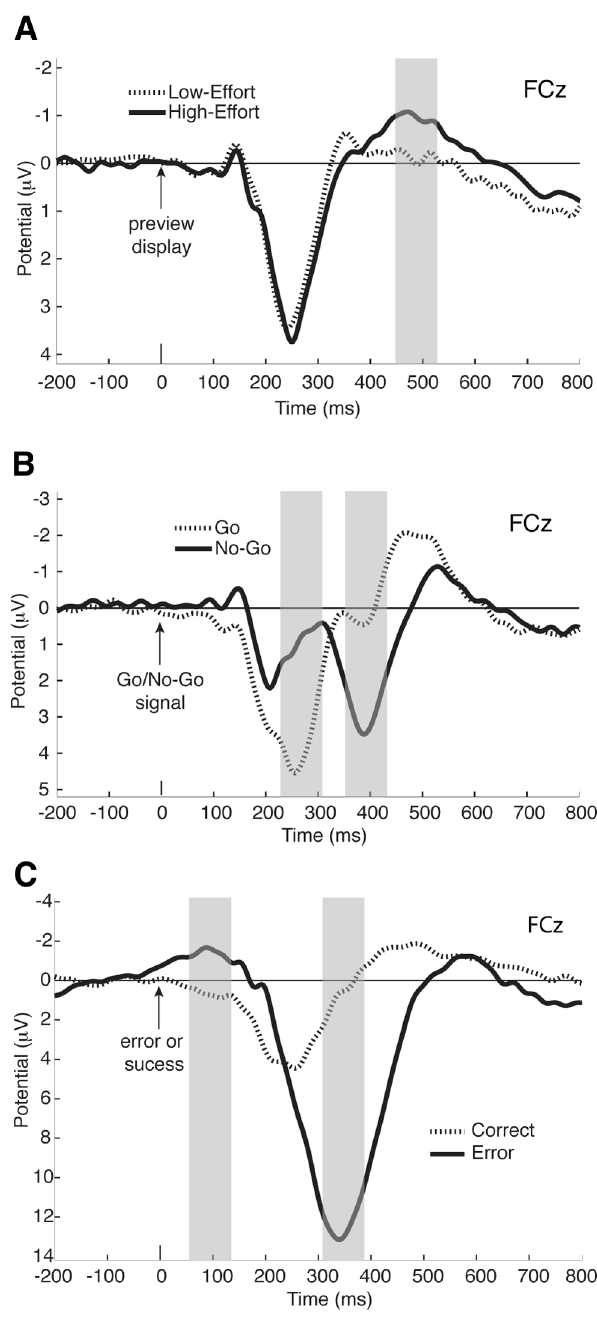
Figure 3. Grand-average ERP waveforms recorded at fronto- central electrode FCz. Negative voltages are plotted upward by convention. Shaded regions represent the time windows used for statistical analyses ( A ) ERPs elicited by the Low-Effort and High-Effort preview displays. ( B ) ERPs elicited by Go and No-Go signals. ( C ) ERPs elicited by errors and correct responses.